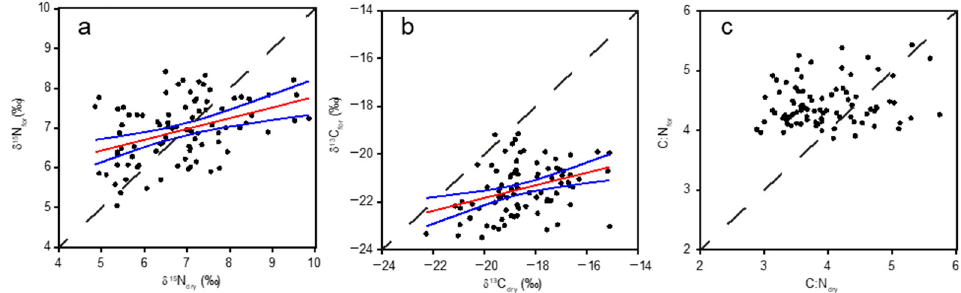
Figure 2. Relationships between measurements of ( a ) δ 15 N, ( b ) δ 13 C, or ( c ) C:N in mesozooplankton samples immediately dried after sampling (dry) or preserved in formalin (for). Signi fi cant ordinary least squares regression lines are indicated in red and the corresponding 95% con fi dence limits are in blue. The dashed line indicates the 1:1 relationship.